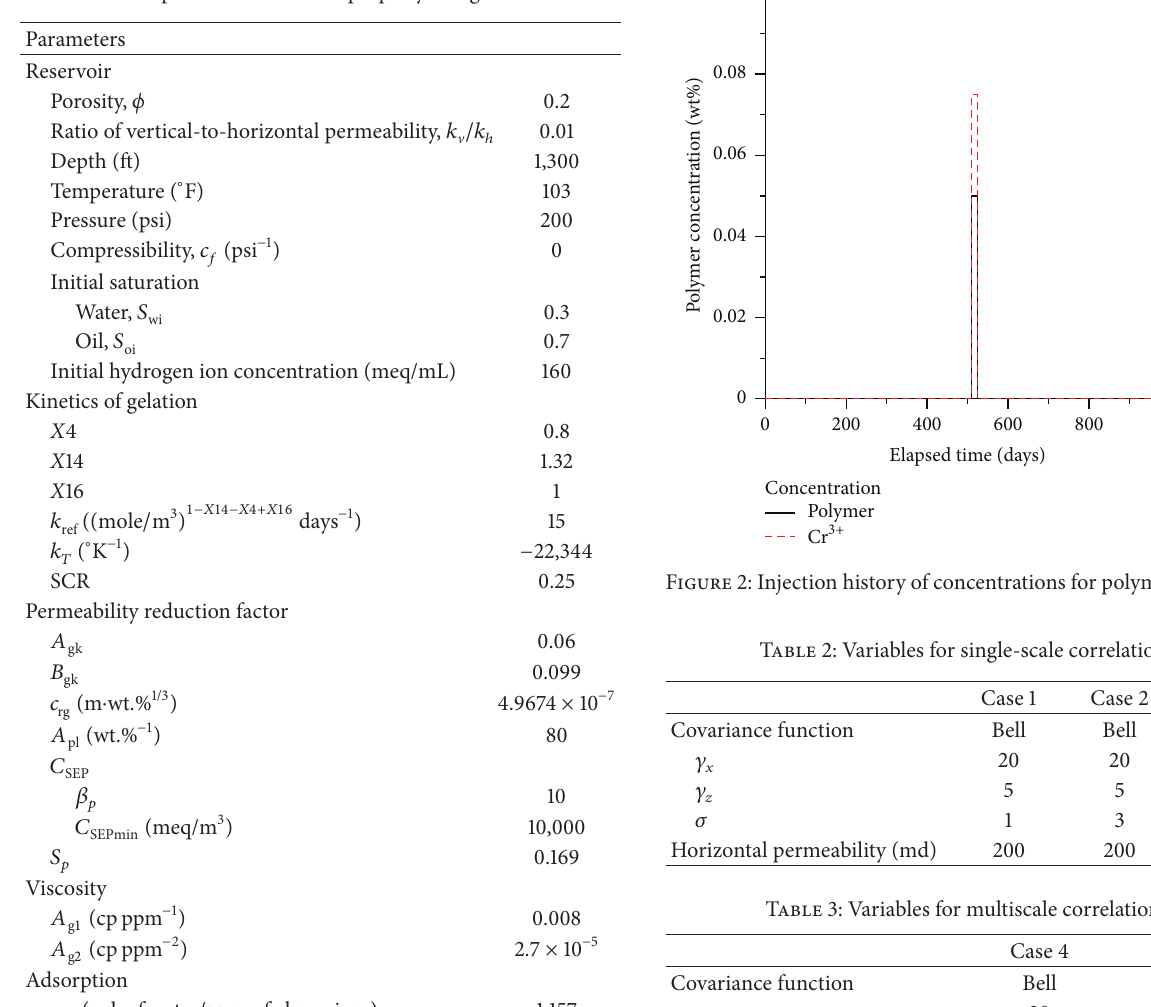
Table 1: Input data of reservoir property and gel reaction.